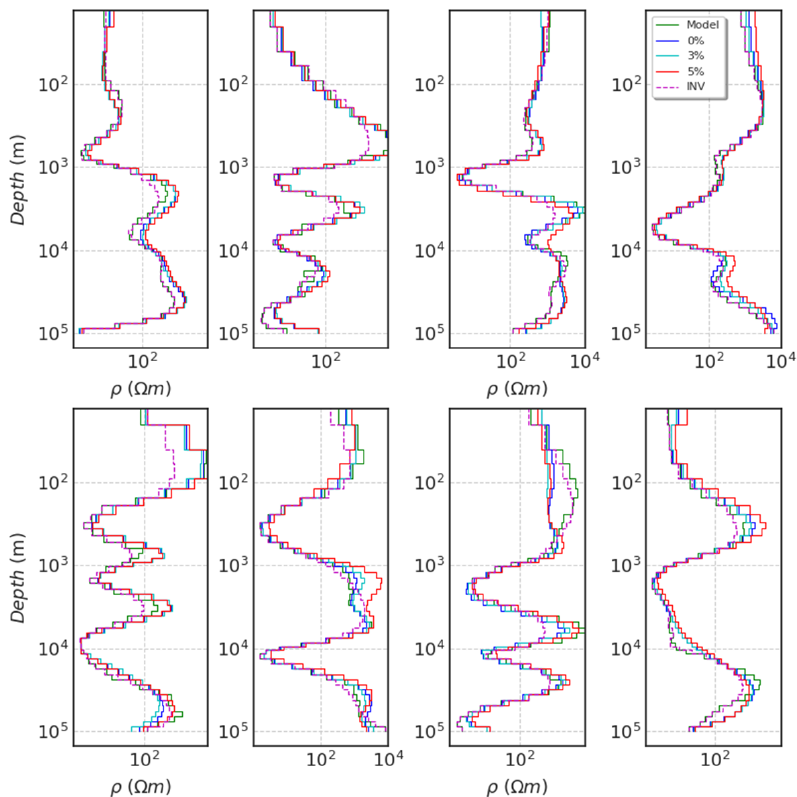
Figure 7. CNN inversion results of 8 synthetic samples at different noise levels (0%, 3%, and 5%) and iterative inversion (INV) results.